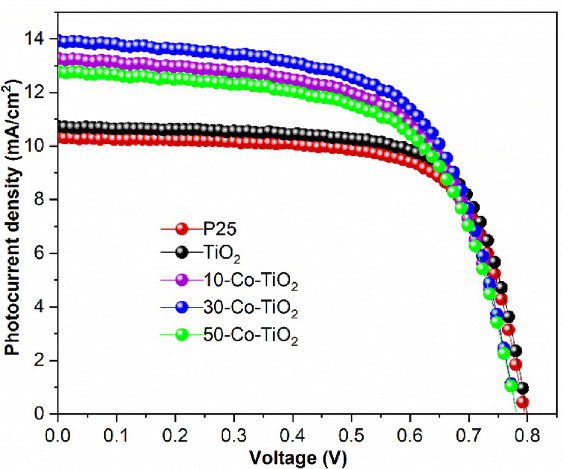
Figure 6. A comparative photocurrent density versus voltage curve ( J–V ) for MOF derived pristine TiO 2 and Co 2+ ion-doped TiO 2 photoanode-based DSSCs.